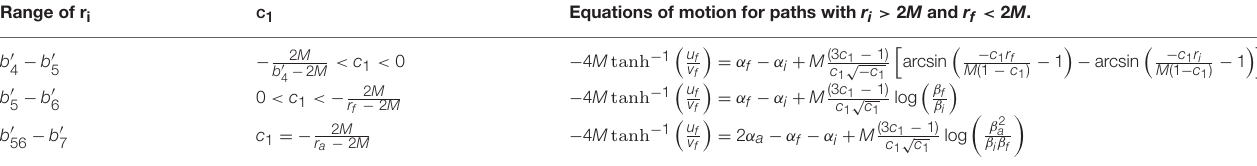
At the light cone boundaries they converge to the form given in Table 4 . All discontinuities cancel each other and there are no singularities anywhere in the equations of motion.